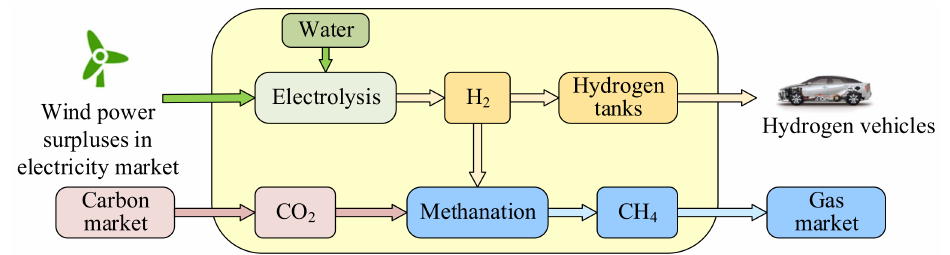
Figure 2. Diagram of energy conversion processes of a P2G